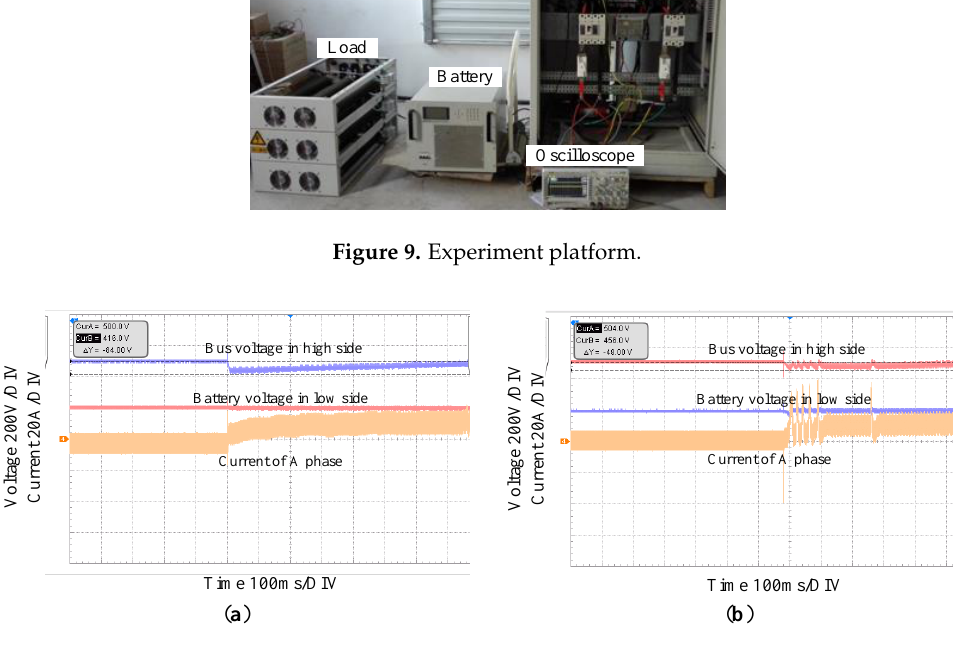
Figure 9. Experiment platform.